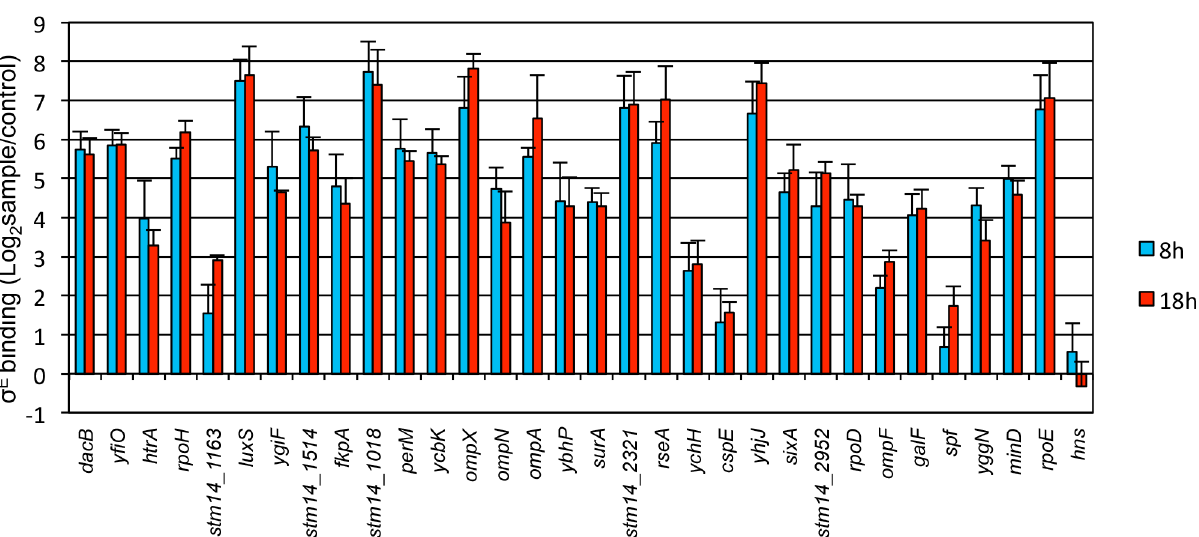
Fig 2. Validation of σ E binding sites obtained with ChIP-seq. Raw264.7 cells were infected with WT bacteria for 8 h or 18 h, crosslinked, lysed, and sonicated for immunoprecipitation with anti- σ E Ab (sample) or anti-GFP Ab (control). After protein and RNA were removed, DNA was extracted as template for qPCR to determine the fold enrichment of the genomic binding loci of σ E in pulldowns with anti- σ E Ab versus anti-GFP Ab. The promoter 3 region of rpoE was used as positive control, and the promoter region of hns was chosen as negative control. Shown are the fold changes displayed in a logarithmic scale. The mean and S.D. values were obtained from independent biological